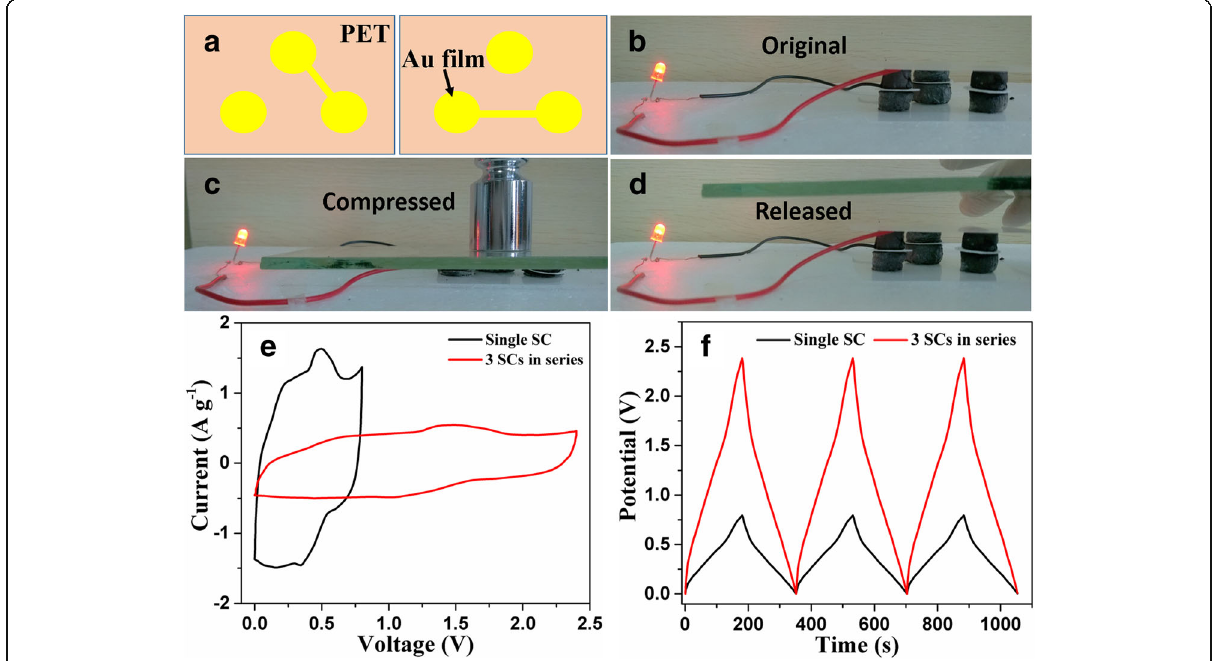
Fig. 8 a Illustration of Au film patterns on PET for integrating three SCs into one unit in series. b – d Photographs of a red-light-emitting diode powered by the integrated device during the compression/release process. e CV curves and f GCD curves of single SC and integrated device. Scan rate 10 mV s − 1 , Current density 0.5 A g −